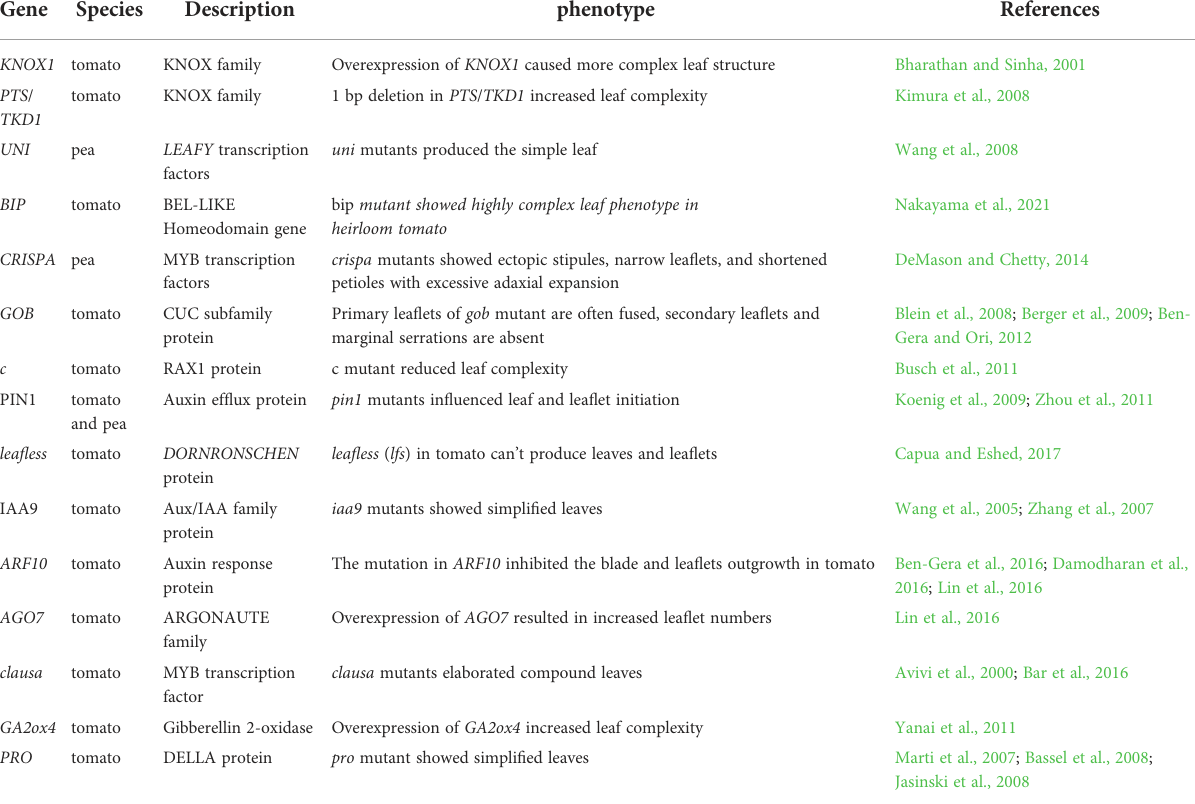
TABLE 1 Genes are involved in leaf complexity in tomato and